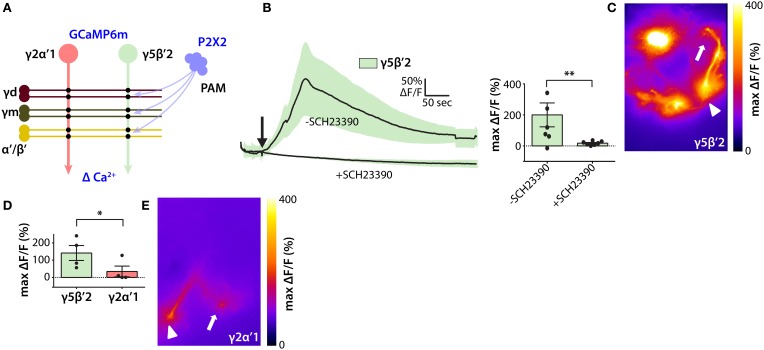
Functional inputs of PAM dopamine neurons to the wake-promoting MB microcircuit. (A) Schematic of experimental design to probe functional connections between wake-promoting PAM neurons and sleep-regulating MBONs. P2X2 ATP-gated depolarizing cation channel was expressed in PAM dopamine neurons, and GCaMP6m fluorescent Ca2+ indicator in MBONs. (B) Ca2+ responses of GCaMP6m-expressing γ5β′2-MBONs following ATP-mediated activation of P2X2 expressed in PAM neurons using R58E02-LexA. Line graph depicts ΔF/F time course in the presence and absence of dopamine receptor D1 subtype blocker SCH23390 (mean ± sem); bar graph depicts peak ΔF/F (mean ± sem). Statistical comparison of peak responses was by unpaired t-test (n = 6 brains per condition). (C) Heat map showing peak Ca2+ response of representative GCaMP6m-expressing γ5β′2-MBONs following ATP-mediated PAM activation. Arrowhead indicates MBON dendrites and arrow indicates axon terminals; panel width is 50 μm. (D) Peak Ca2+ responses of GCaMP6m-expressing γ2α′1 and γ5β′2-MBONs after ATP-mediated activation of P2X2-expressing PAM neurons. γ5β′2-MBONs respond more strongly than γ2α′1 to PAM activation. Quantification and statistical analysis as in (B) (n = 4 brains per genotype). (E) Heat map showing peak Ca2+ response of GCaMP6m-expressing MBON-γ2α′1 following ATP-mediated PAM activation. Symbols as in (C); panel width is 50 μm. *p < 0.05; **p < 0.01.